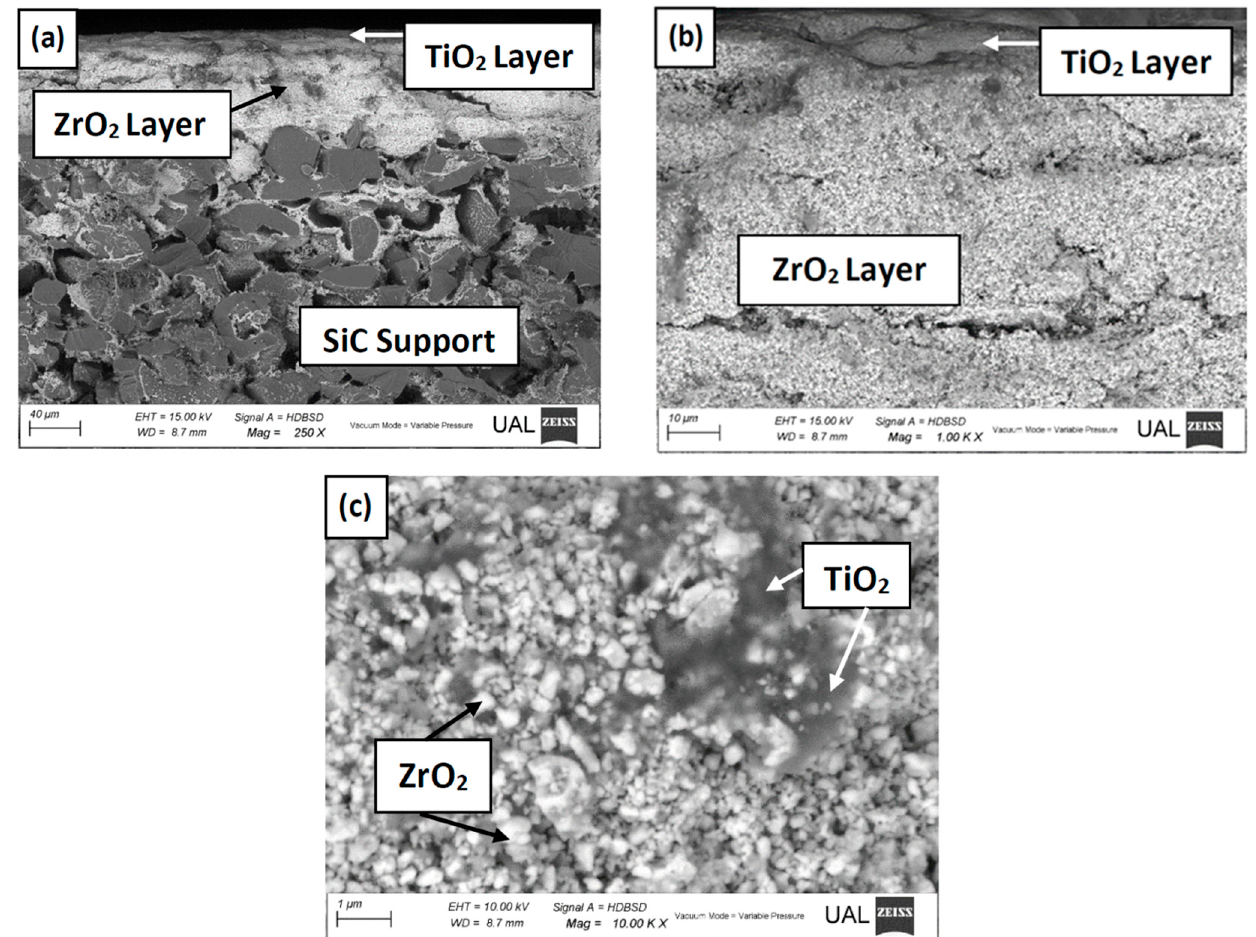
Figure 1. SEM images of a cross-section of the membrane: ( a ) the triple-layer membrane construction, showing the SiC support in grey, followed by the ZrO 2 intermediate UF membrane layer, while the grey shadows on top are the TiO 2 wash coating; ( b ) side view and ( c ) top view, showing the intermediate ZrO 2 UF membrane layer covered by the TiO 2 wash coating. The presence of the ZrO 2 and the TiO 2 wash coating was confirmed by